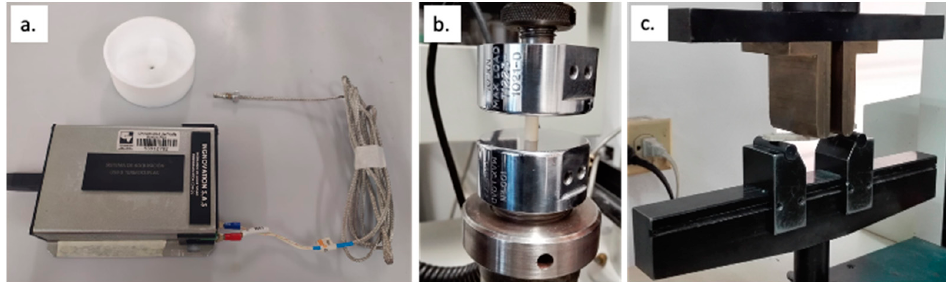
Figure 3. Equipment used for data acquisition. ( a ) setting test, ( b ) compressive properties, and ( c ) bending